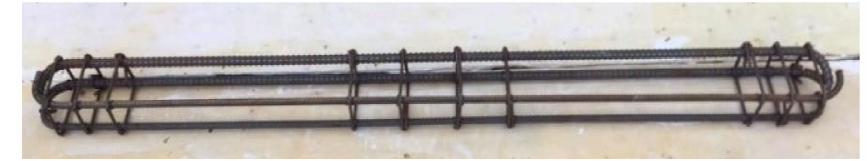
Figure 7. Typical view of steel